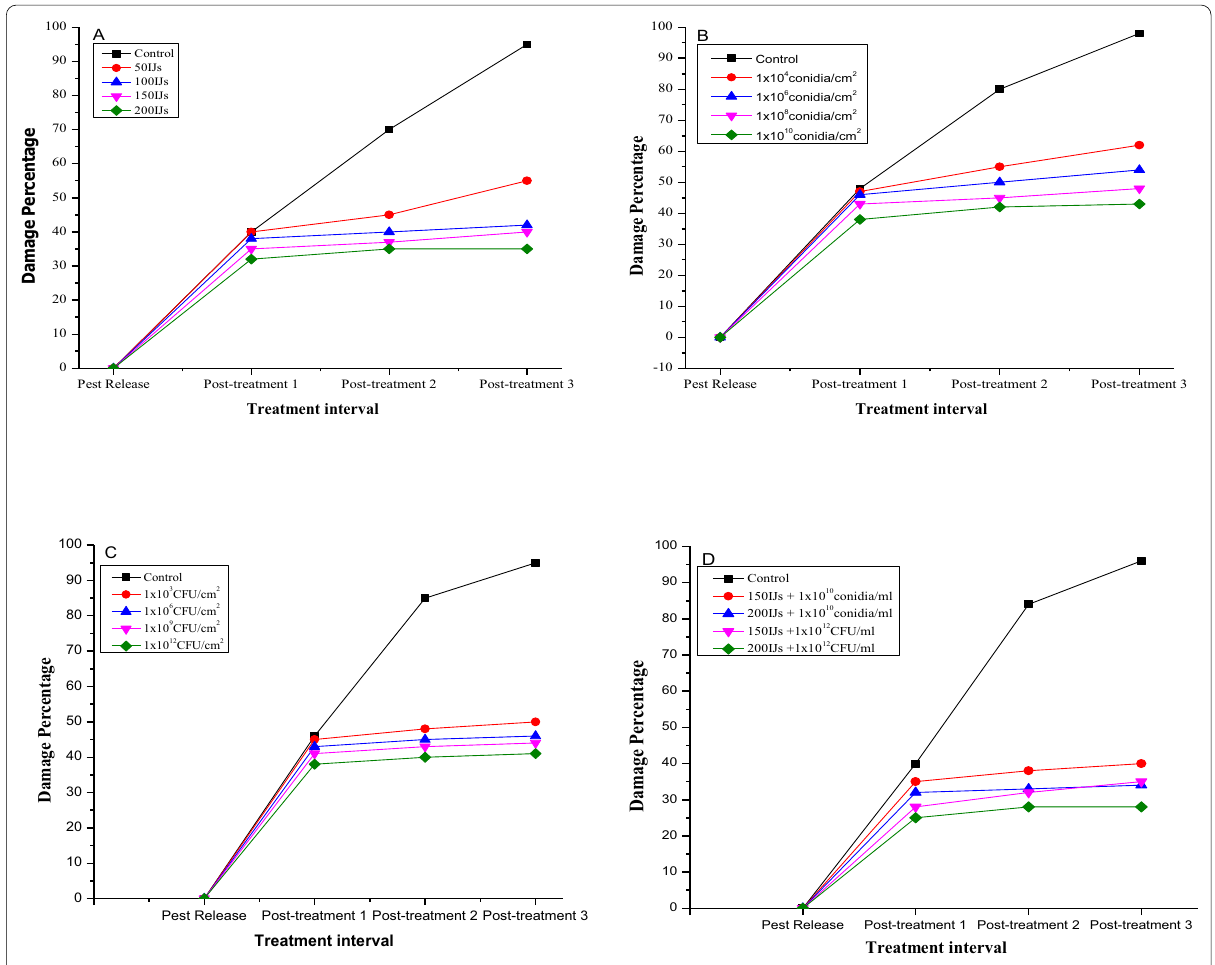
Fig. 2 Application of entomopathogens on capsicum plants against Spodoptera litura (3rd instar) As: A Heterorhabditis bacteriophora , B Beauveria bassiana , C Bacillus thuringiensis , D H. bacteriophora